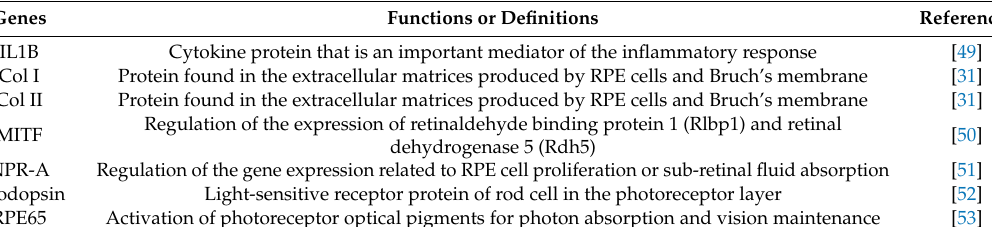
Table 2. Seven RPE-related genes used in the RT-PCR.